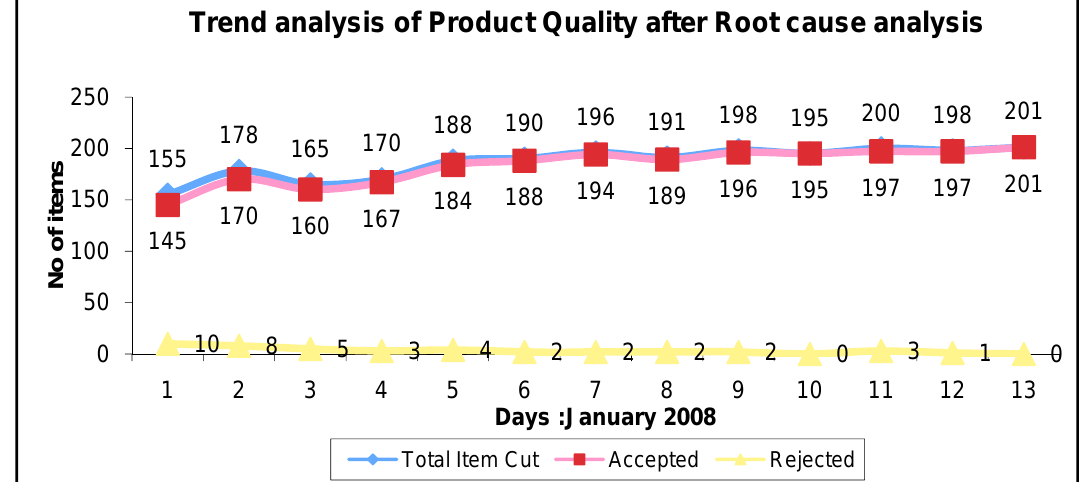
Figure 5. “Trend analysis of cutting products after root cause elimination”.